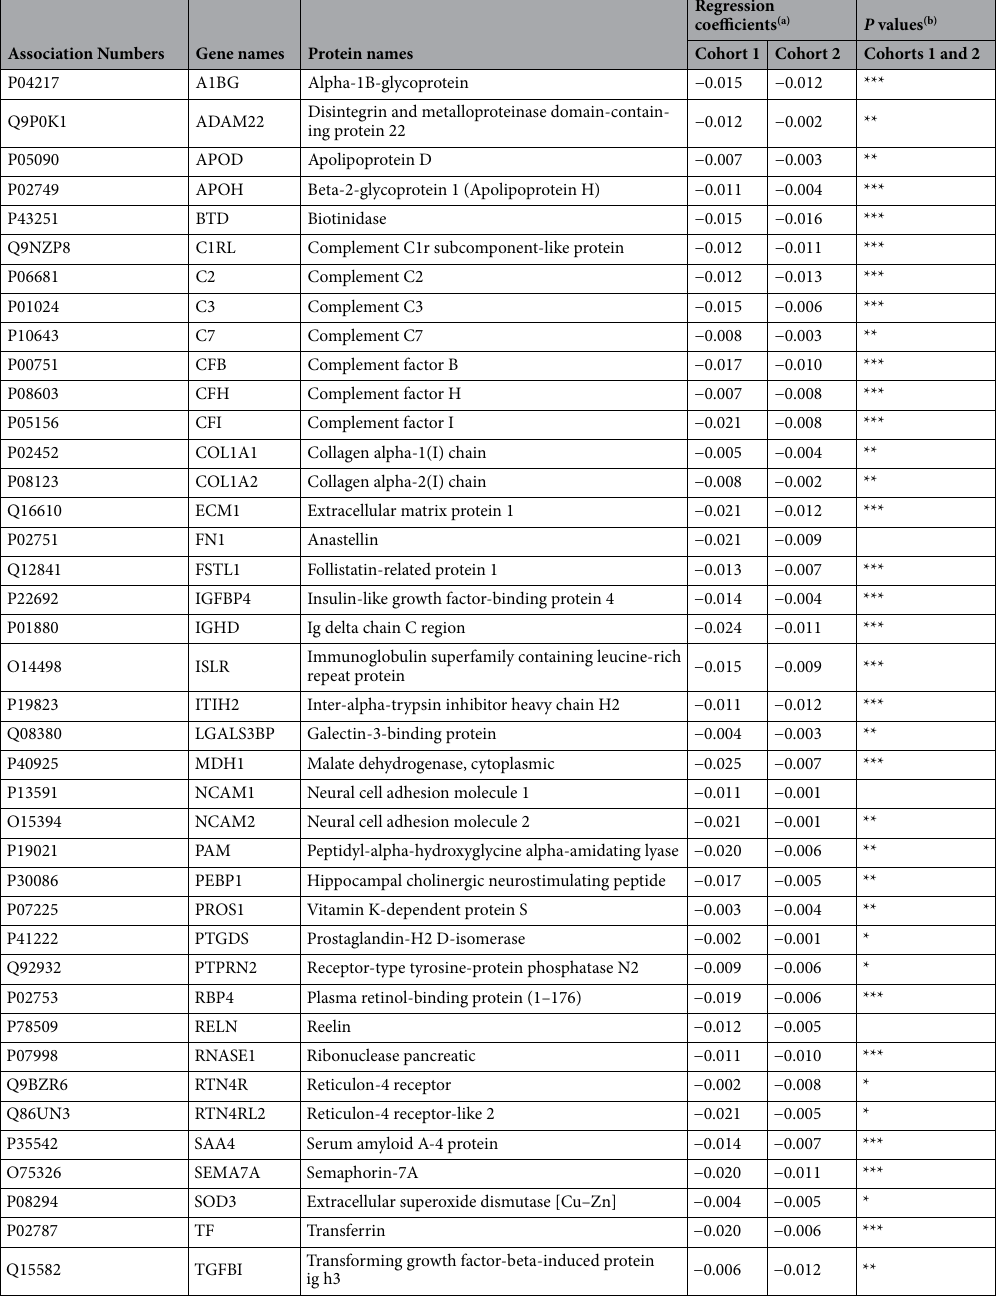
Table 2. Proteins selected by Martens’ uncertainty test 23 in the multivariate analysis PLS-DA for discrimination of MS/CIS versus controls with consistent negative regression coefficients in a model with 2 PLS factors. (a) Regression coefficients from PLS-DA within each cohort at two PLS factors. (b) FDR-adjusted p-values (presented by one, two or three stars for p > 0.05, p < 0.01 and p < 0001, respectively) based on univariate validation by two-way ANOVA of the combined data of 163 individuals from cohort 1, groups A and B (after omitting the effects of group affiliation by ER modelling) and cohort 2, group A. The data on 357 proteins analysed in both two cohorts were